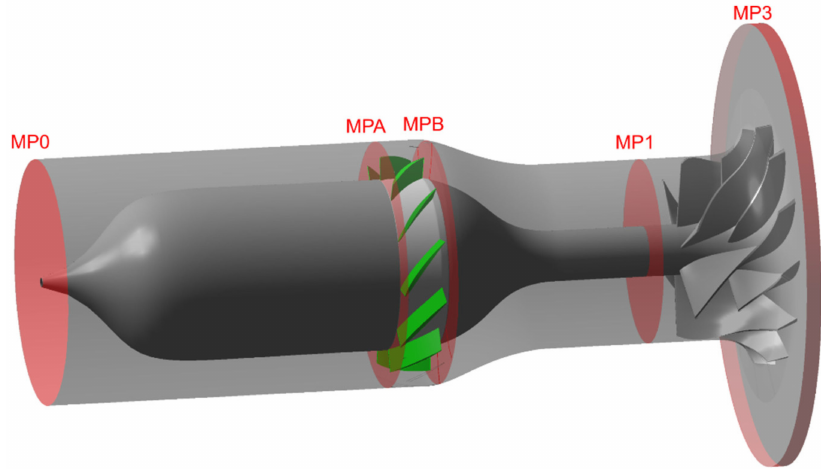
Figure 6. Rendering of complete CFD computational